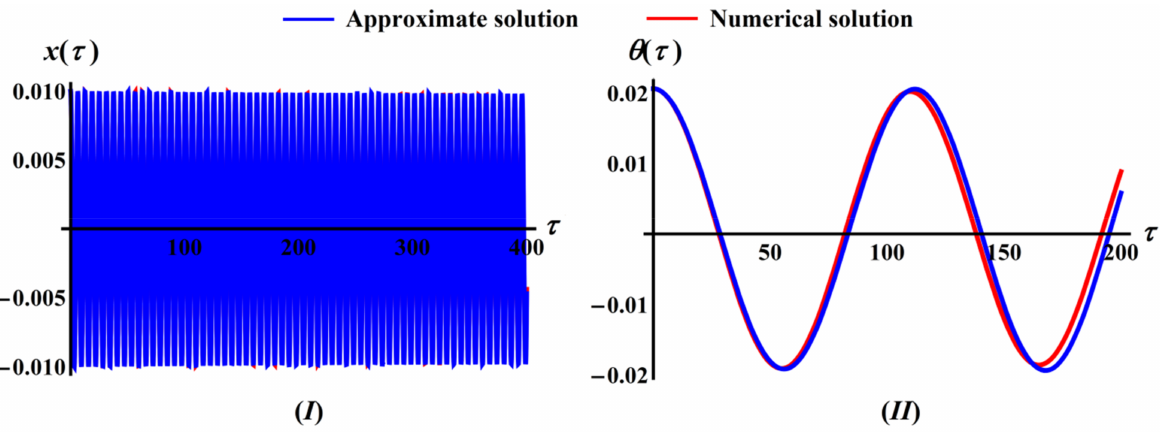
Figure 6. The comparison between the numerical and the approximate solutions for: ( I ) x ( τ ) and ( II ) θ ( τ )